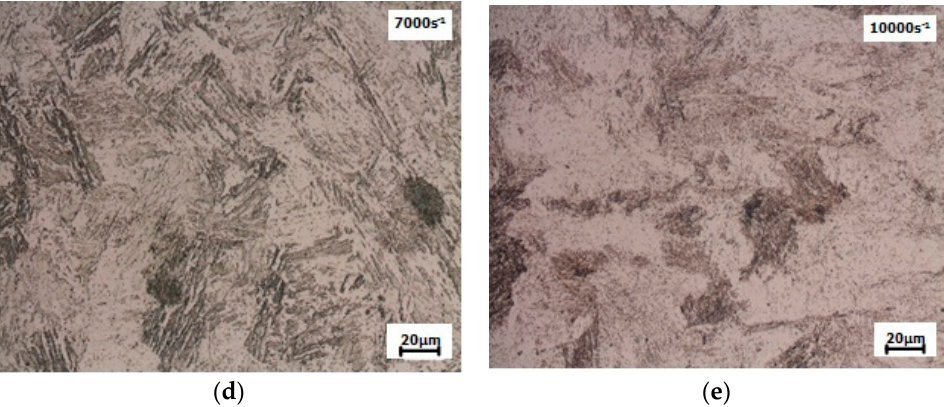
Figure 7. True stress–strain curves ( a ) and its corresponding optical photomicrographs of SHPB tested samples deformed at 800 °C with strain rate ( b ) 1000 s − 1 ; ( c ) 4000 s − 1 ; ( d ) 7000 s − 1 and ( e ) 10,000 s − 1 .